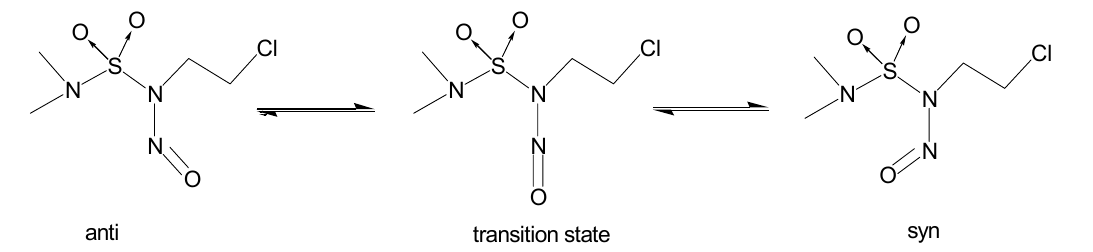
Figure 6 : Anti, syn and transition state